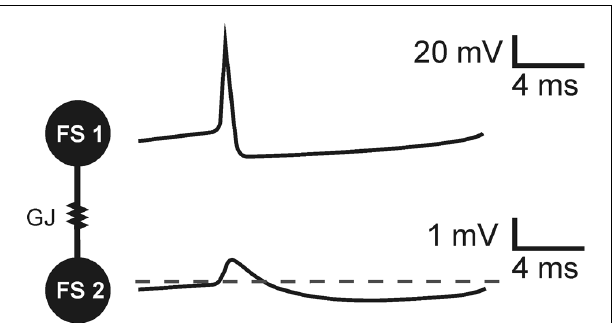
FIGURE 1 |The transmission of threshold excitation through a GJ containing Cx36 subunit in a pair of FS interneurons. Image based on original data from Gibson etal. (2005). In response to action potential generated in a presynaptic cell (FS 1), a biphasic potential is mediated through the GJ to a postsynaptic FS cell (FS 2). Due to low-pass filtering of Cx36-GJs, fast spike is more attenuated than slow afterhyperpolarization. The biphasic potential in a postsynaptic cell is composed of a small- amplitude short depolarizing phase and long-lasting hyperpolarization in a postsynaptic FS